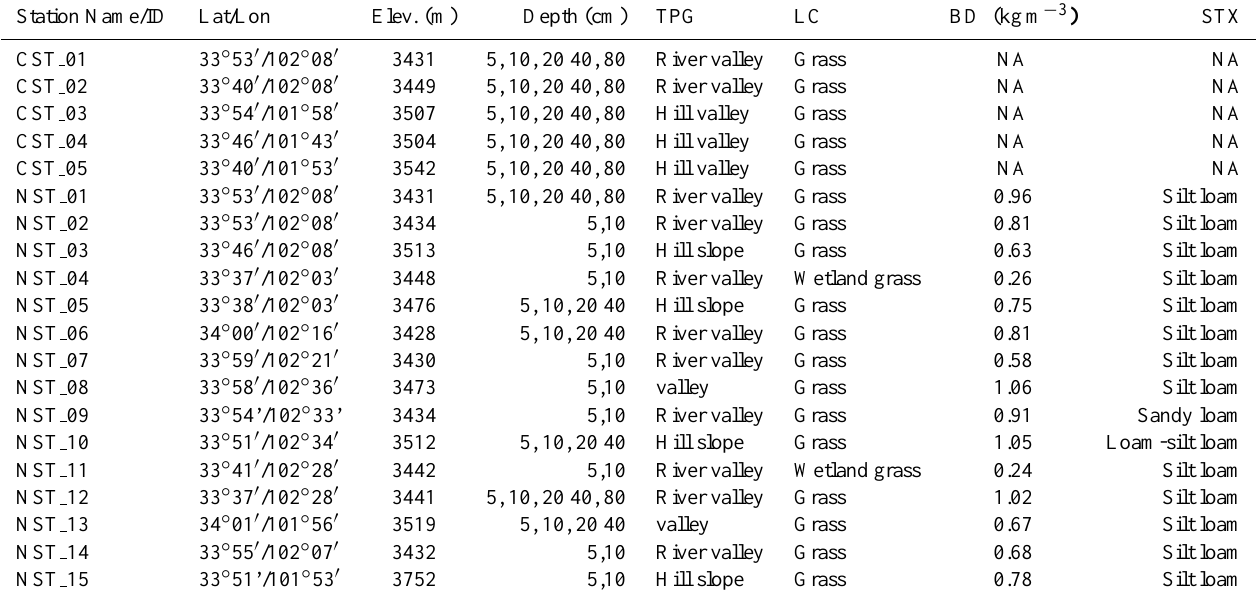
Table 2. Maqu network station information (station name, geographical coordinates, elevation a.s.l., depth of probes, location topography (TPG), land cover (LC), soil bulk density at 5cm depth (BD), soil texture at 5–15cm depth (STX), soil organic matter content at 5–15cm depth (OMC), Not Available